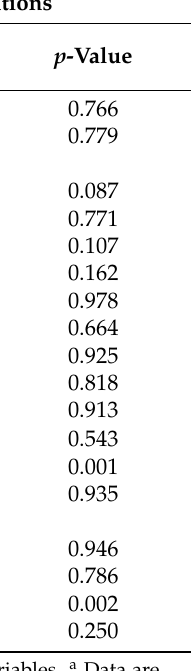
Table 1. Baseline characteristics % ( n ) * of the AF populations with and without CR and exercise before and after propensity score matching. Initial Populations Propensity Score Matched